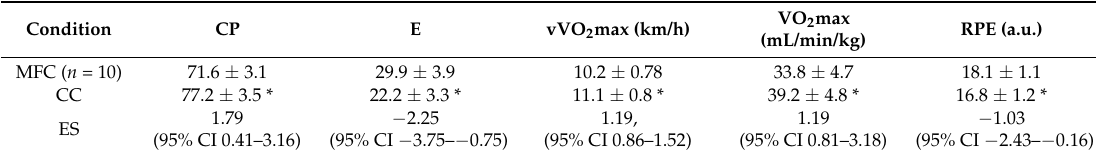
Table 1. Mean values and standard deviations (SD) of the attention test, aerobic performance variables and rating of perceived exertion